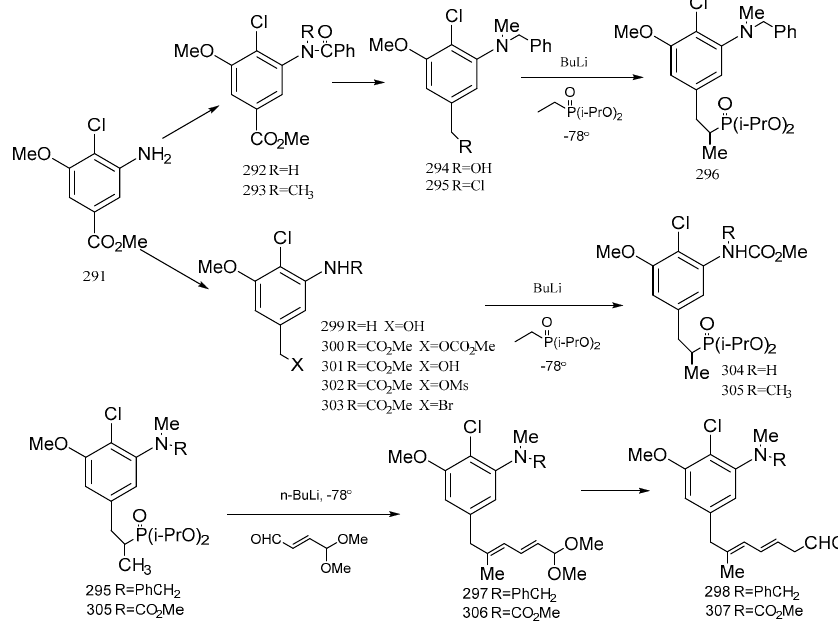
Figure 12. The synthetic by-products of the western-southern fragments of maytansine.